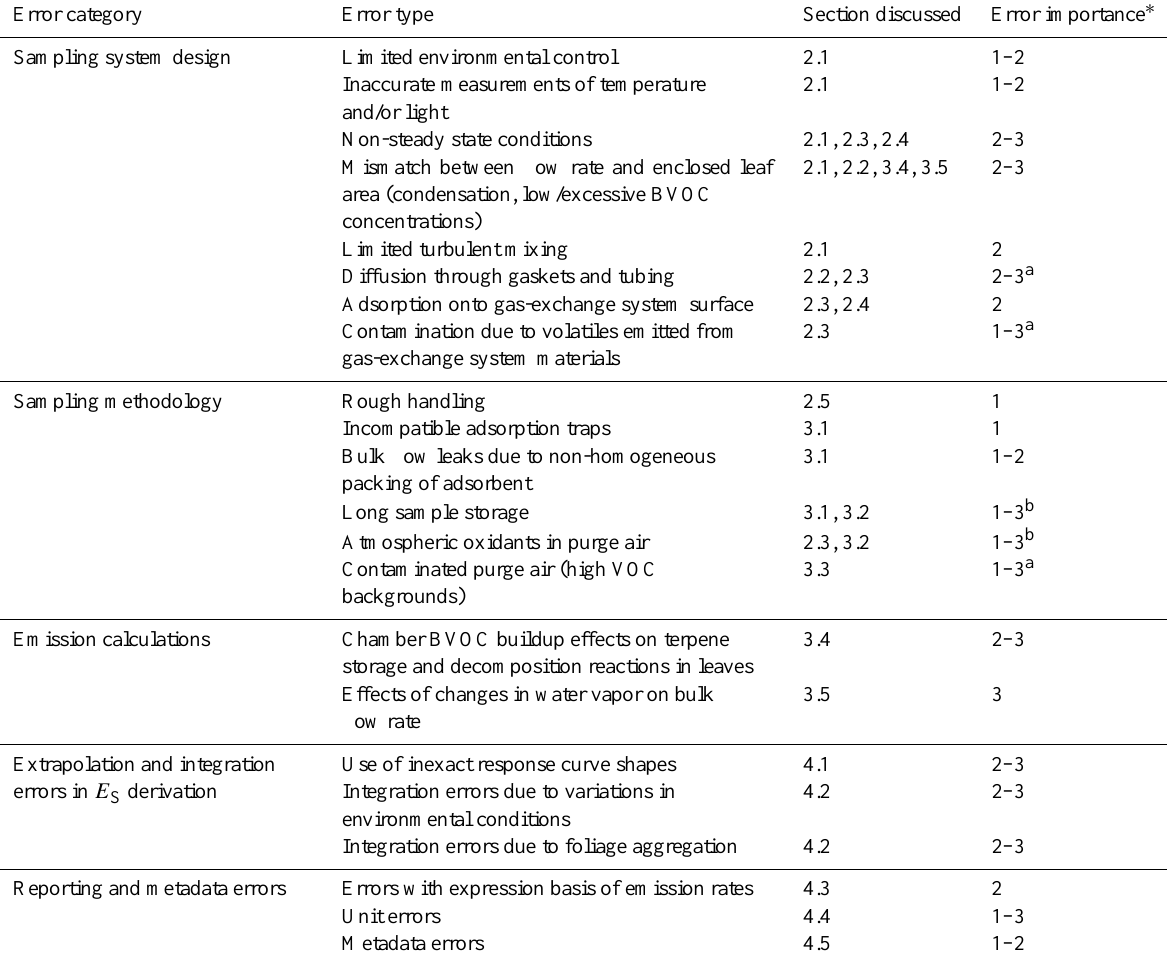
Table 1. Summary of error sources in derivation of the BVOC emission factors and significance of different error